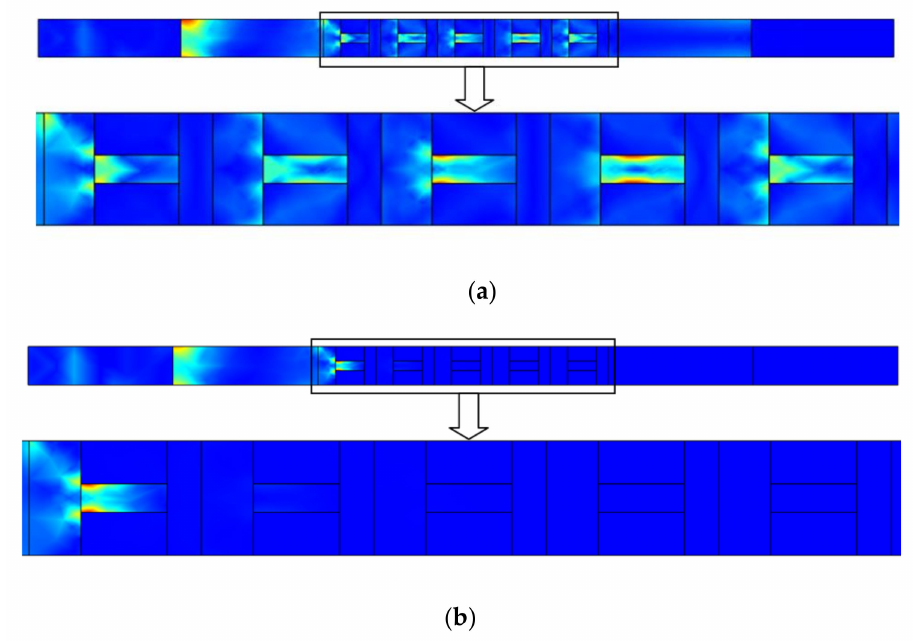
Figure 19. A and B displacement field, ( a ) point A, ( b ) point